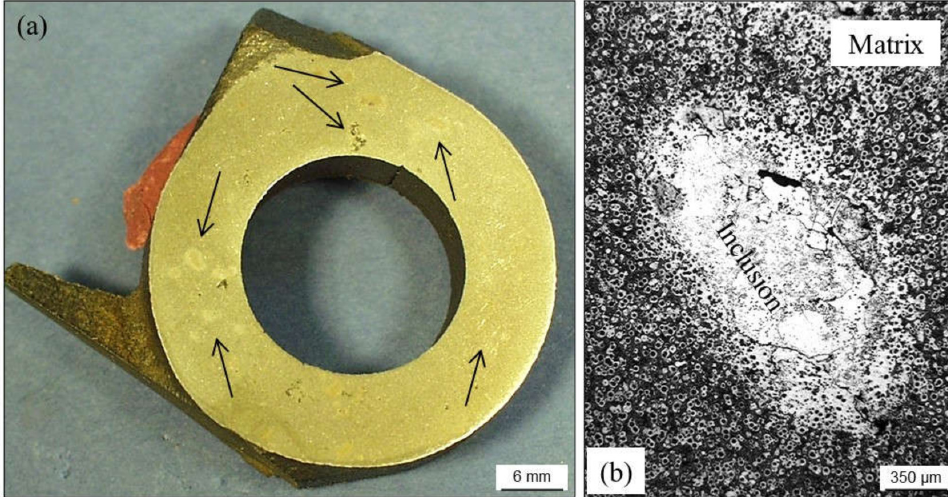
Figure 40. A group of metallic inclusions found in a polished cross section of a ductile iron casting ( a ). Optical micrograph of one of these defects after etching with Nital for 10–15 s ( b ).